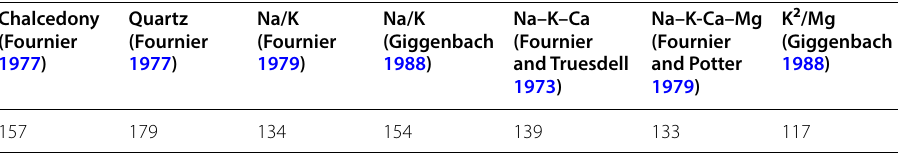
Table 3 Geothermometer calculations for MH-2B (all values in °C) Chalcedony